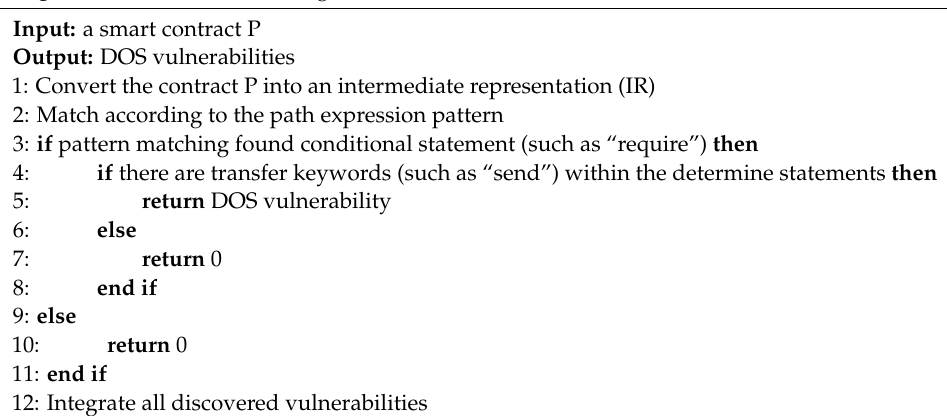
Algorithm 5: DOS detection